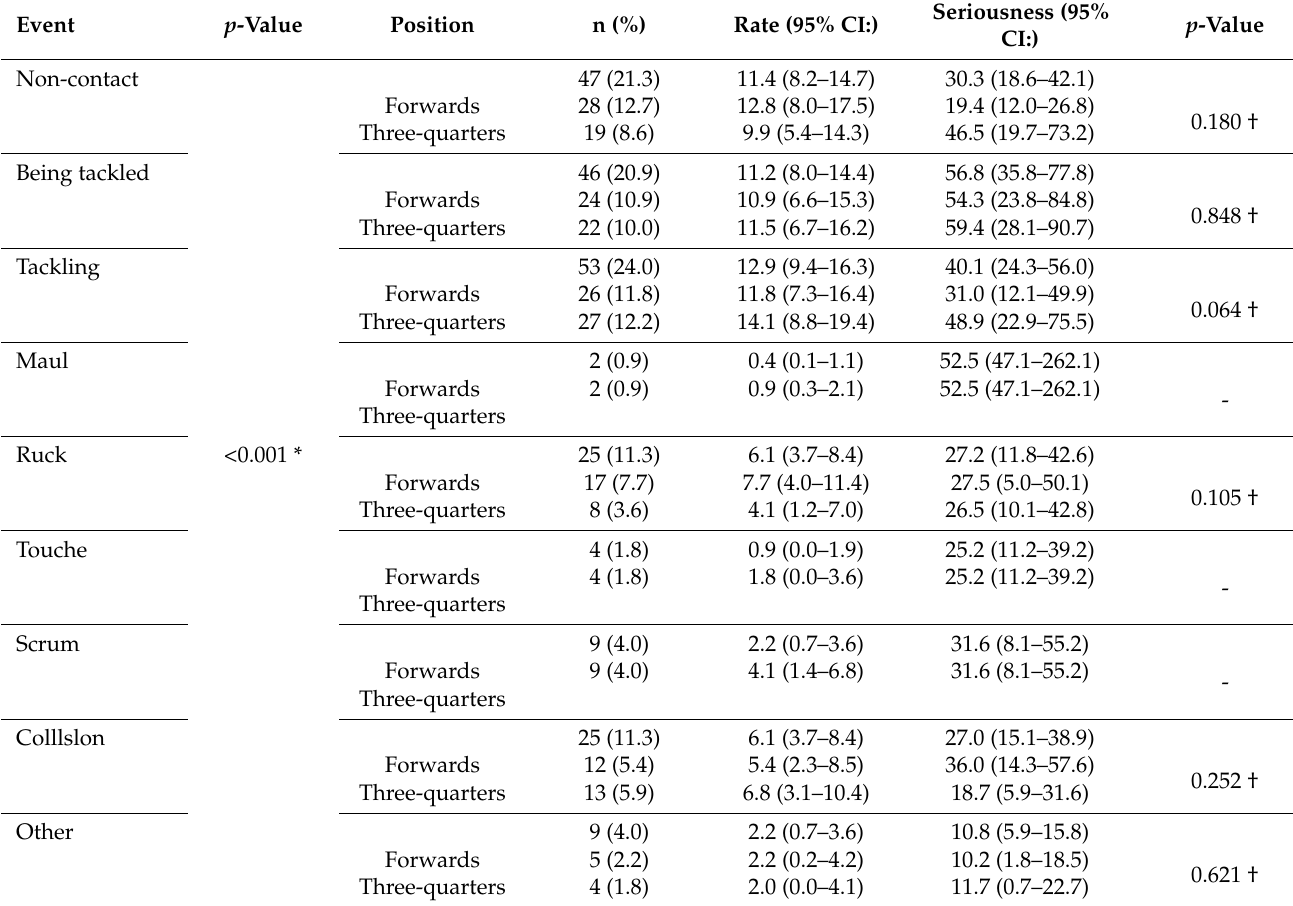
Table 6. Events associated with match